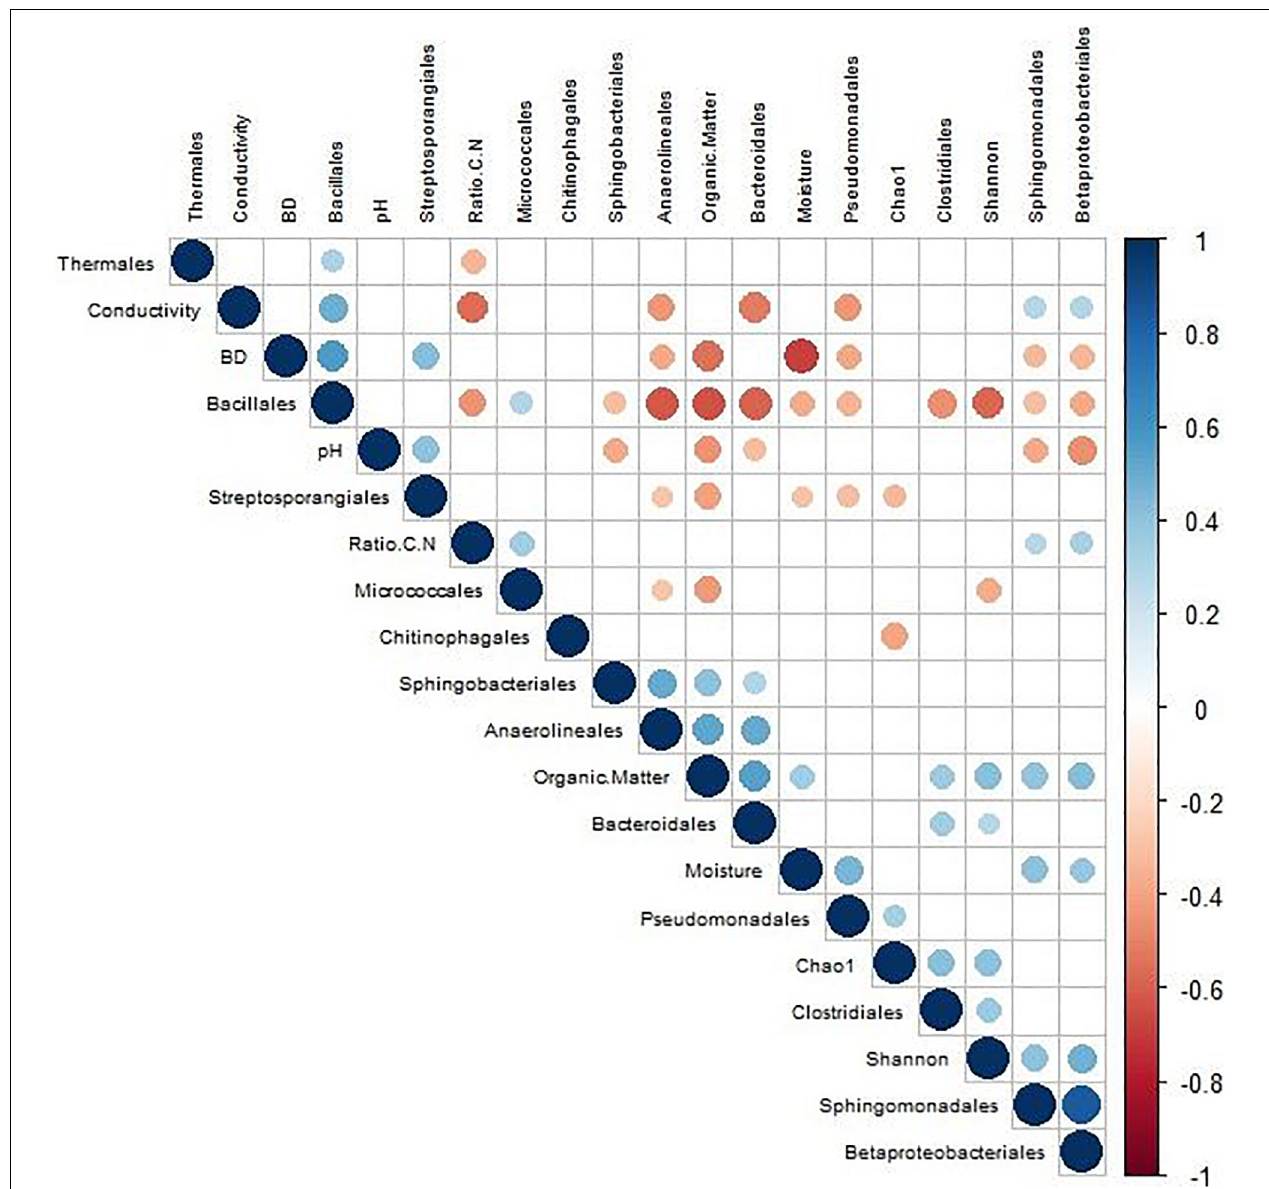
FIGURE 5 | Pearson’s correlation analysis based on composting of different sewage sludge processes, taking into account the monitoring parameters, biodiversity indices, and most important